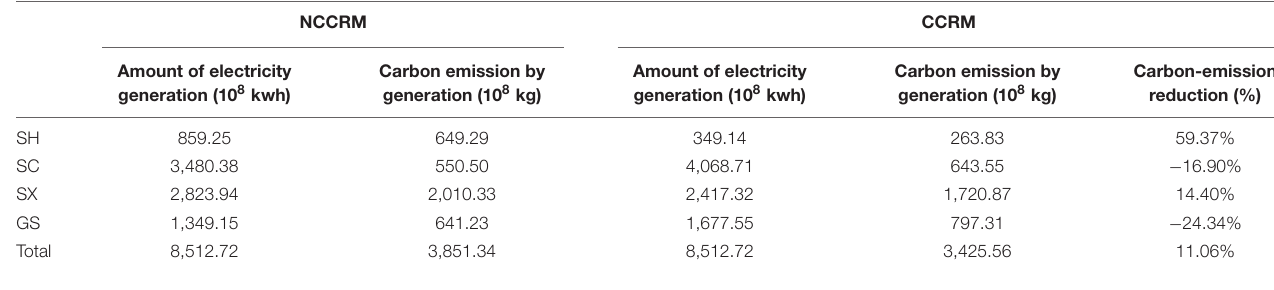
TABLE 6 | Amounts of electricity generation and carbon emission under two